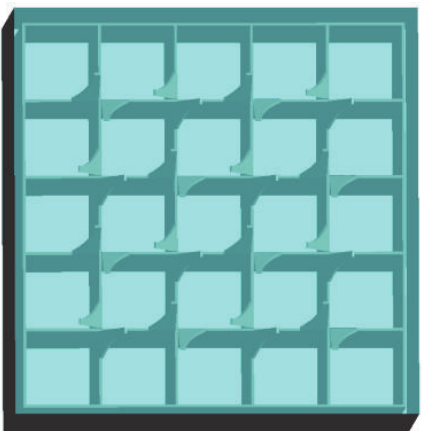
Figure 2: Experimental spacer grid of